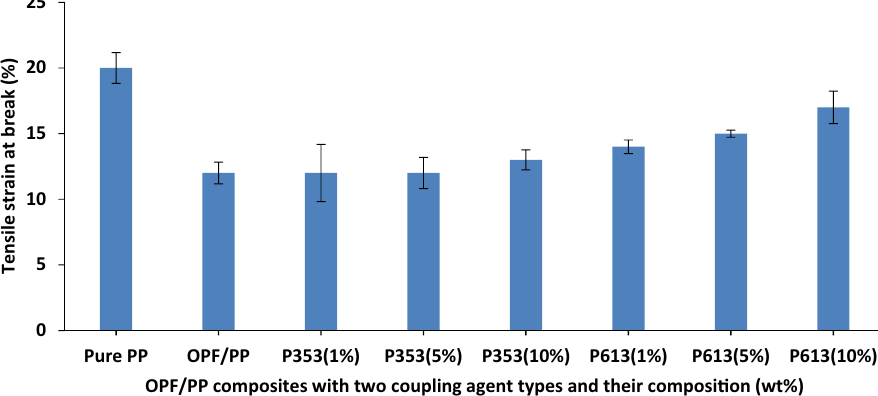
Figure 5: Tensile strain at break of the pure PP, uncoupled, and coupled 20% OPF/PP polymer composite with two coupling agent types of di ff erent weight percentages.